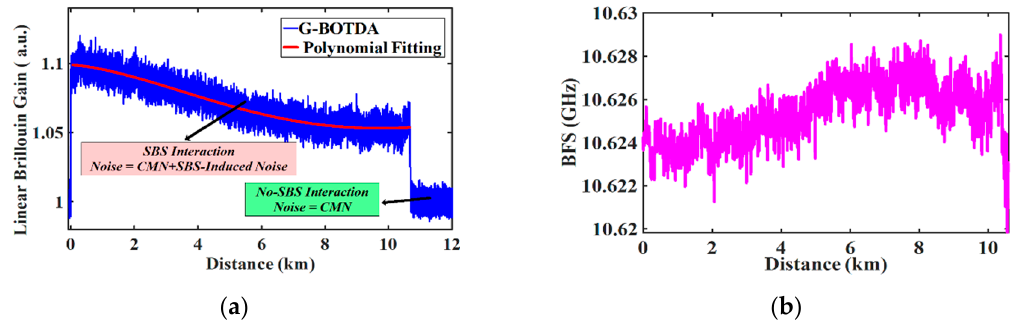
Figure 4. ( a ) Measured G-BOTDA time domain trace for 10.6 km fiber; ( b ) measured Brillouin frequency shift (BFS) profile of the fiber.